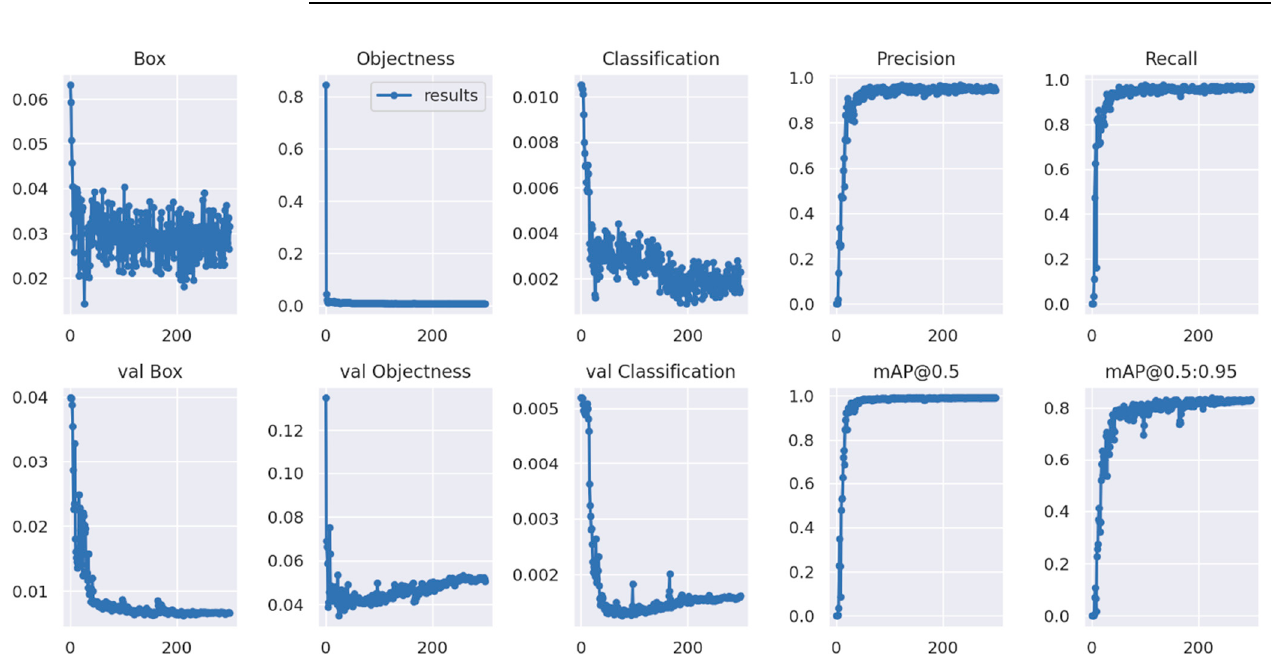
Figure 7. The YOLOv7 model training and validation main metrics.